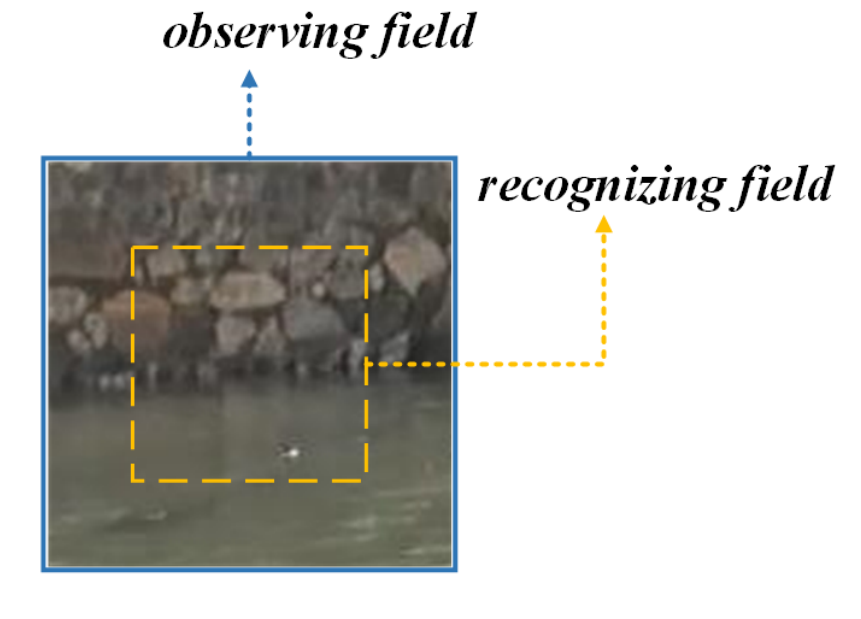
Figure 2. An illustrative example of WLpeephole (here, r = 64 and s =